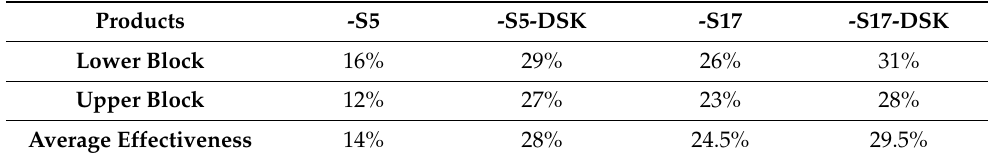
Table 3. Effect of the double-size skid on temperature non-uniformity reduction of blocks in Config-1 compared to